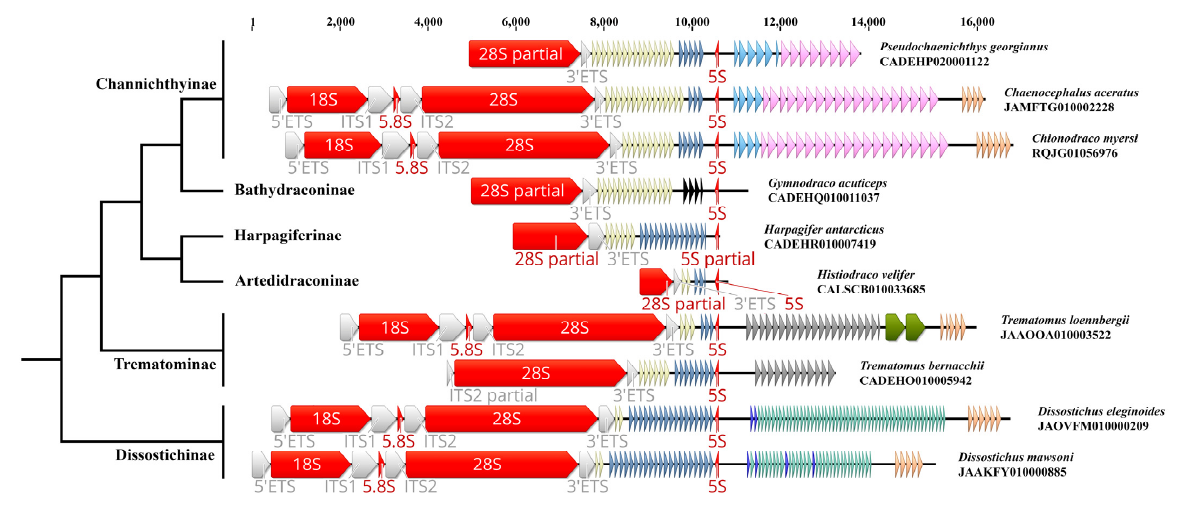
Figure 1. Ribosomal genes encoding the 18S, 5.8S, 28S, and 5S rRNA, found in WGS contigs of ten Nototheniidae species. NOR-5S rDNA orientation is opposite to 45S rDNA. The NOR-5S rRNA gene is located within a unique region between the IGS internal repeats. Nototheniidae phylogeny is given according to [44].